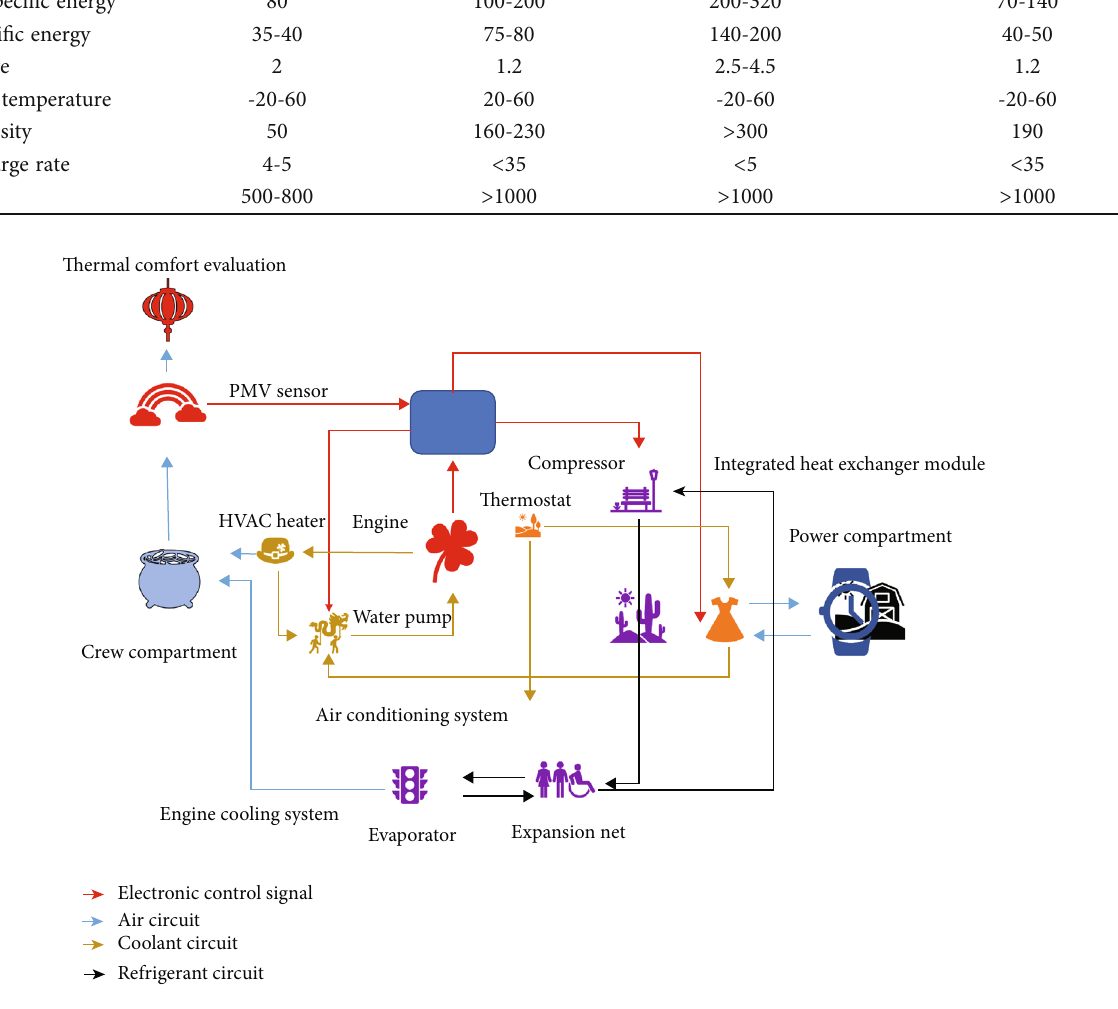
Figure 2: Architecture block diagram of integrated thermal management system for new energy